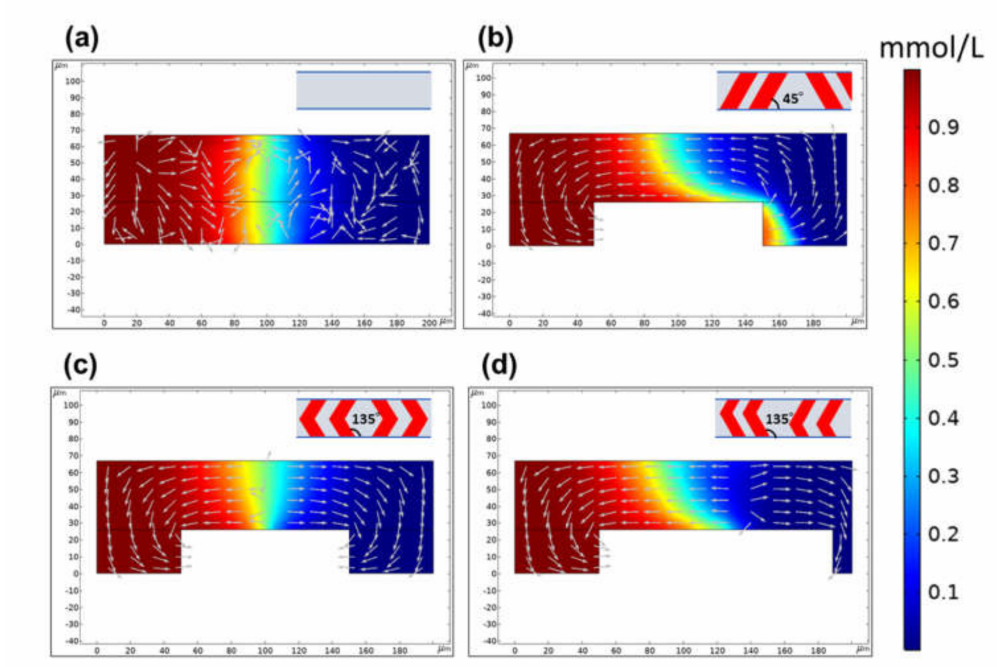
Figure 11. The concentration distribution (contour) and transverse velocity fields (arrows) across the microchannel cross-section at the position y = 0.45 mm away from the inlet. ( a ) Rectangular microchannel without ridges. ( b ) Chaotic mixer with oblique ridges, ( c ) symmetric V-shaped ridges, and ( d ) asymmetric V-shaped ridges.